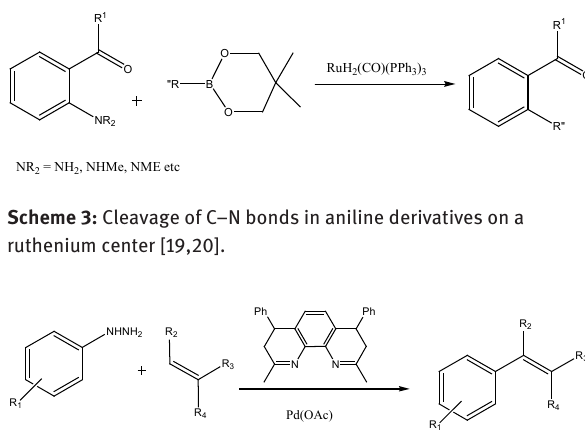
Scheme 4: Palladium catalyzed C–N bond cleavage resulting in C-C coupling